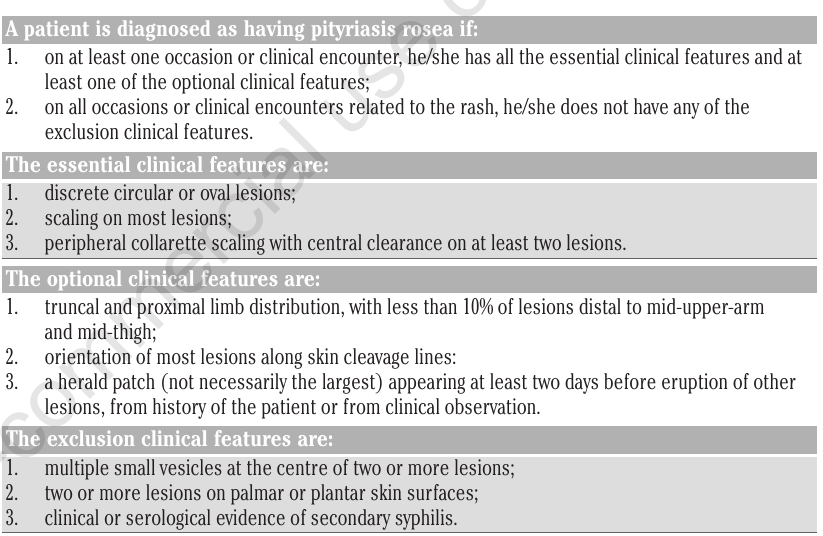
Table 2. Proposed diagnostic criteria for pityriasis rosea. 116